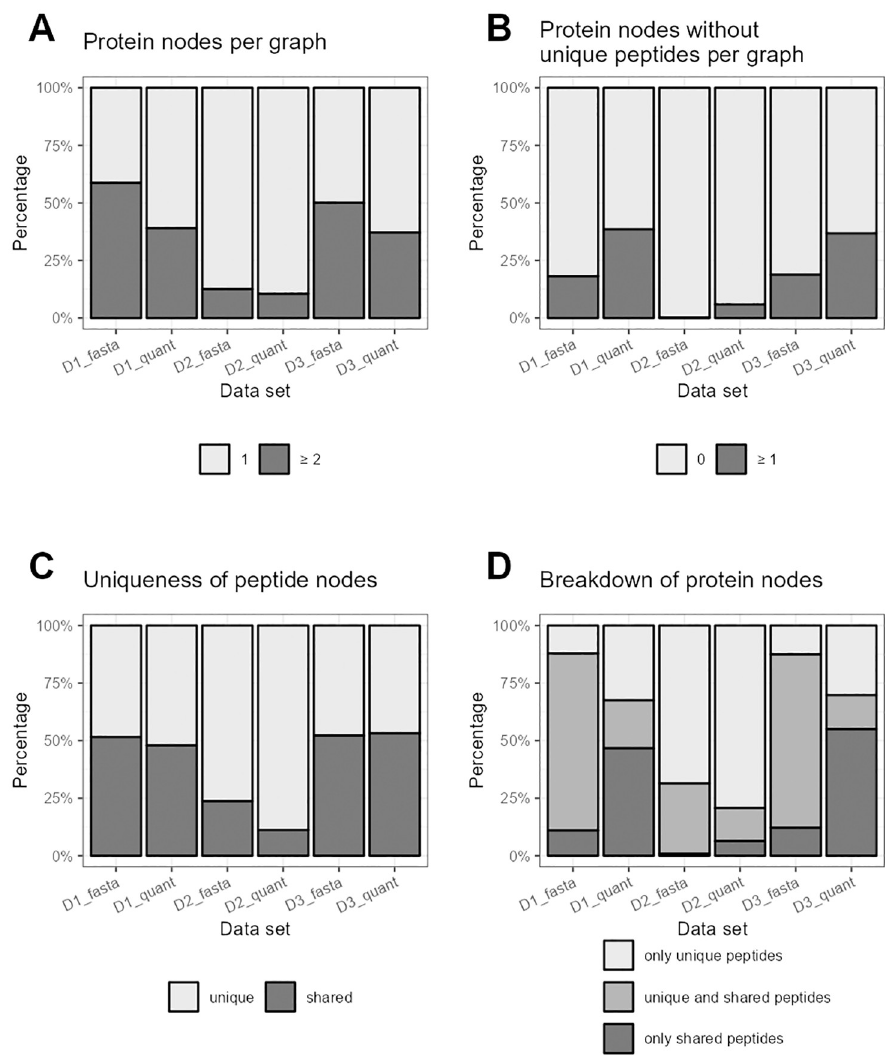
Fig 3. Aggregated characteristics of bipartite peptide-protein graphs over the different data sets. A: Percentages of graphs with one or with more than one protein node. The light grey bars reflects the percentage of the most simple graph type with only one protein node compared to all graphs. The dark grey bars represents the percentage of all larger graphs with two or more protein nodes. B: Percentages of graphs with none vs. one or more protein nodes, that are not connected to any unique peptide node. In the graphs represented by the light grey bars, each protein node has at least one unique peptide. In the graphs represented by the dark grey bars, at least one protein node exists without a unique peptide (which is a more complicated case for protein inference and quantification). C: Percentages of unique vs. shared peptide nodes in relation to all peptide nodes across all bipartite peptide-protein graphs. Uniqueness is here defined as belonging to only one protein node, which may consist of multiple protein accessions. D: Percentages of protein nodes with only unique peptides vs. unique and shared peptides vs. only shared peptides in relation to all protein nodes across all bipartite peptide-protein graphs. Uniqueness of the peptide nodes is here defined as belonging to only one protein node, which may consist of multiple protein accessions. Please note: As described in the ‘Methods’ section, peptide nodes may contain multiple peptide sequences and protein nodes may contain multiple protein